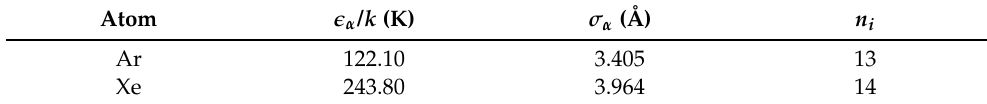
Table 1. Mie potential parameters used for Ar and Xe, taken from Ref. [23].